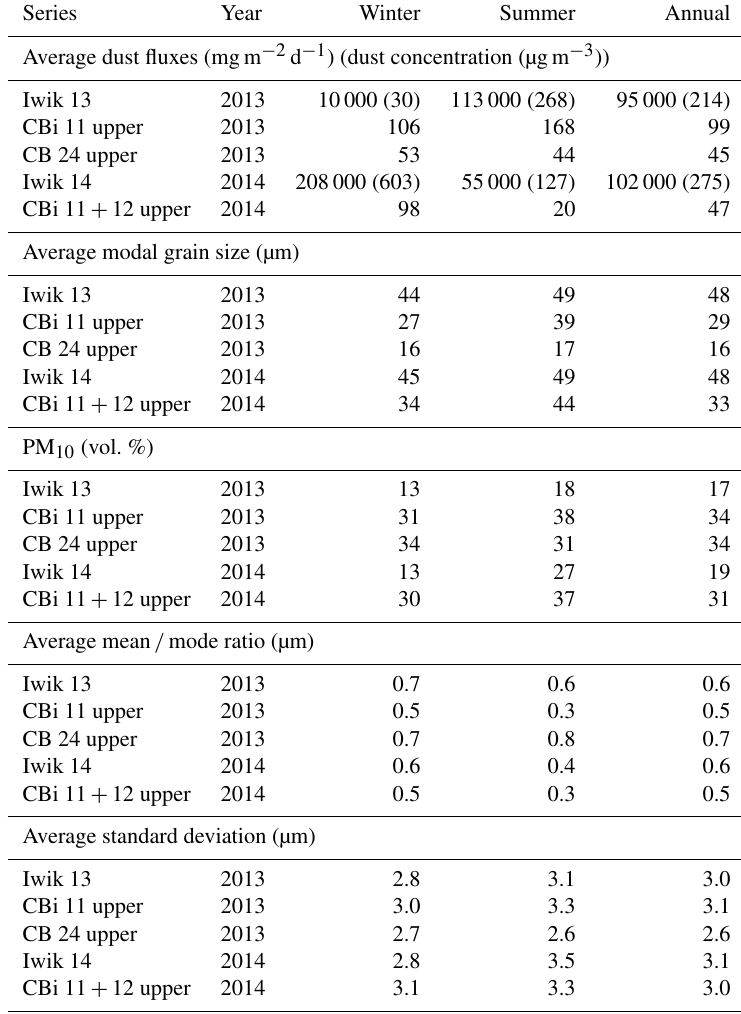
Table 5. Seasonal and annual average dust fluxes and average modal grain size, mean / mode ratio and standard deviation of the grain-size distributions from Iwik 13-14, CBi 11-12 upper and CB 24 upper time